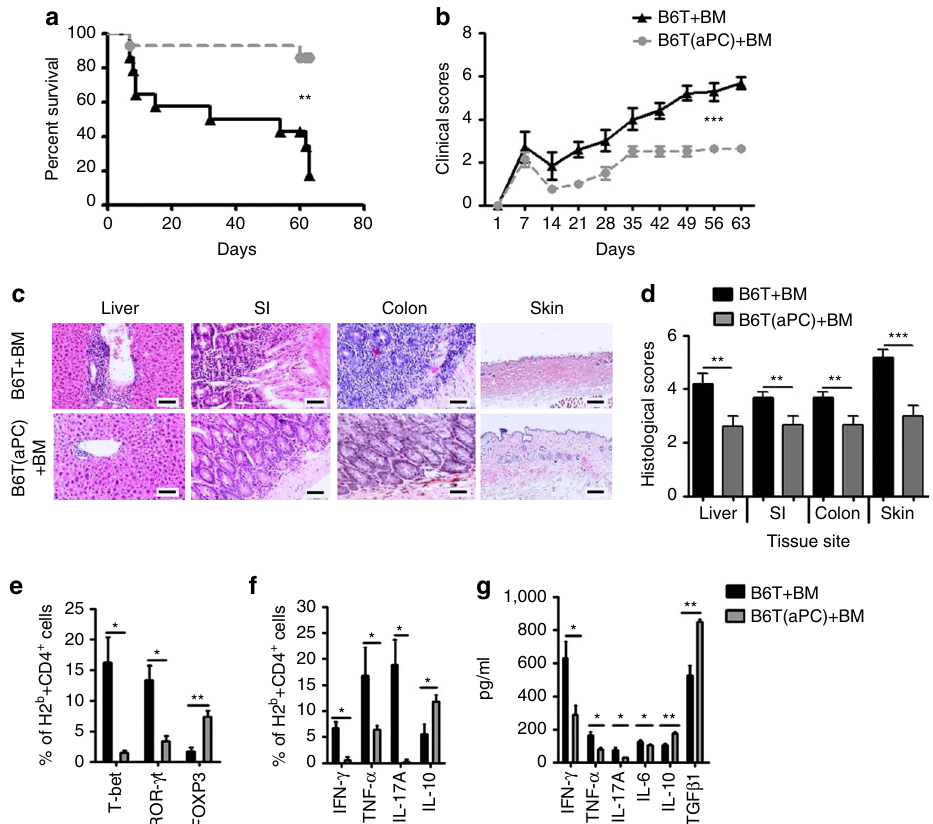
Fig. 3 T-cell preincubation with aPC ameliorates GvHD in mice. a , b Recipient BALB/c mice were lethally irradiated (11 Gy) and transplanted with 5 × 10 6 BM and 0.5 × 10 6 T-cells without (B6T + BM) or with (B6T(aPC) + BM) aPC-preincubation (20 nM, 1 h, 37 °C) from donor C57BL/6 wt mice. Recipient mice were monitored for survival ( a Kaplan – Meier curve) and physical parameters ( b clinical score); pooled data from three independent experiments each with four recipients per group. c , d Photomicrographs ( c ) depicting typical morphology in liver, small intestine ( SI ), colon, and skin and bar graph ( d ) summarizing histological disease score. e , f In separate experiments recipients were euthanized 2 weeks post transplantation, splenic T-cells were harvested and stained for H2 b , CD4, T-bet, ROR- γ t, or FOXP3 ( e ) or H2 b , CD4, IFN- γ , TNF- α , IL-17, or IL-10 ( f ) and analysed by fl ow cytometry; pooled data from three independent experiments each with four recipients per group. g Cytokines (IFN- γ , TNF- α , IL-17, IL-6, IL-10, and TGF β 1) were measured by ELISA in mouse plasma samples ( N = 12 per group) collected from recipient mice euthanized 2 weeks post transplantation. Mean value ± SEM ( d – g ); haematoxylin and eosin stained sections ( c size bar: 50 µ m); MFI and exemplary FACS images corresponding to Fig. 3e, f are shown in Supplementary Figs. 2 and 3; * P < 0.05, ** P < 0.01, *** P < 0.001 ( a log-rank test; b ANOVA; d – g : t